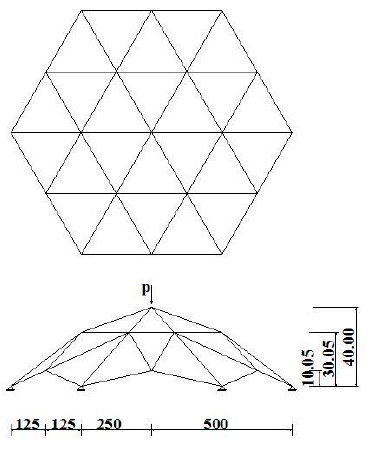
Figure 4. Space truss with 42 – members, all dimensions are in mm [28] .